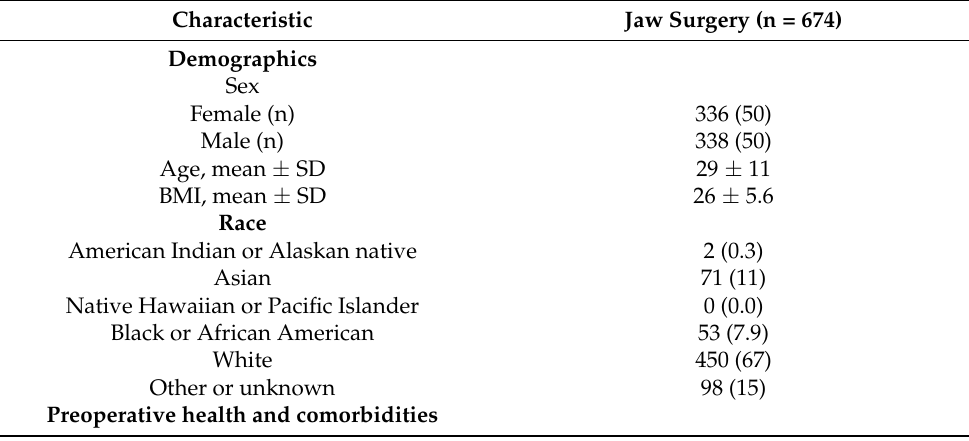
Table 1. Patient demographics and comorbidities. Reported as n